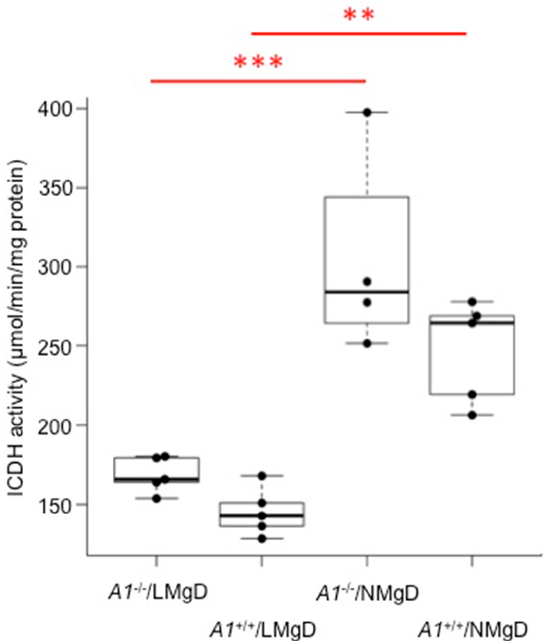
Figure A3. Post-hoc Tukey’s range test / ACON. The ACON activities presented as box-and-whisker plot overlaid with dot plot; dots represent raw input values for each analyzed group ( Slc41a1 − / − animals on LMgD, Slc41a1 +/+ animals on LMgD, Slc41a1 − / − animals on NMgD, and Slc41a1 +/+ animals on NMgD); * p < 0.05. Abbreviations: ⦿ , trend towards significance ( p < 0.1); A1 , ACON, aconitate hydratase; Slc41a1 ; LMgD, low Mg diet; NMgD, normal Mg diet.